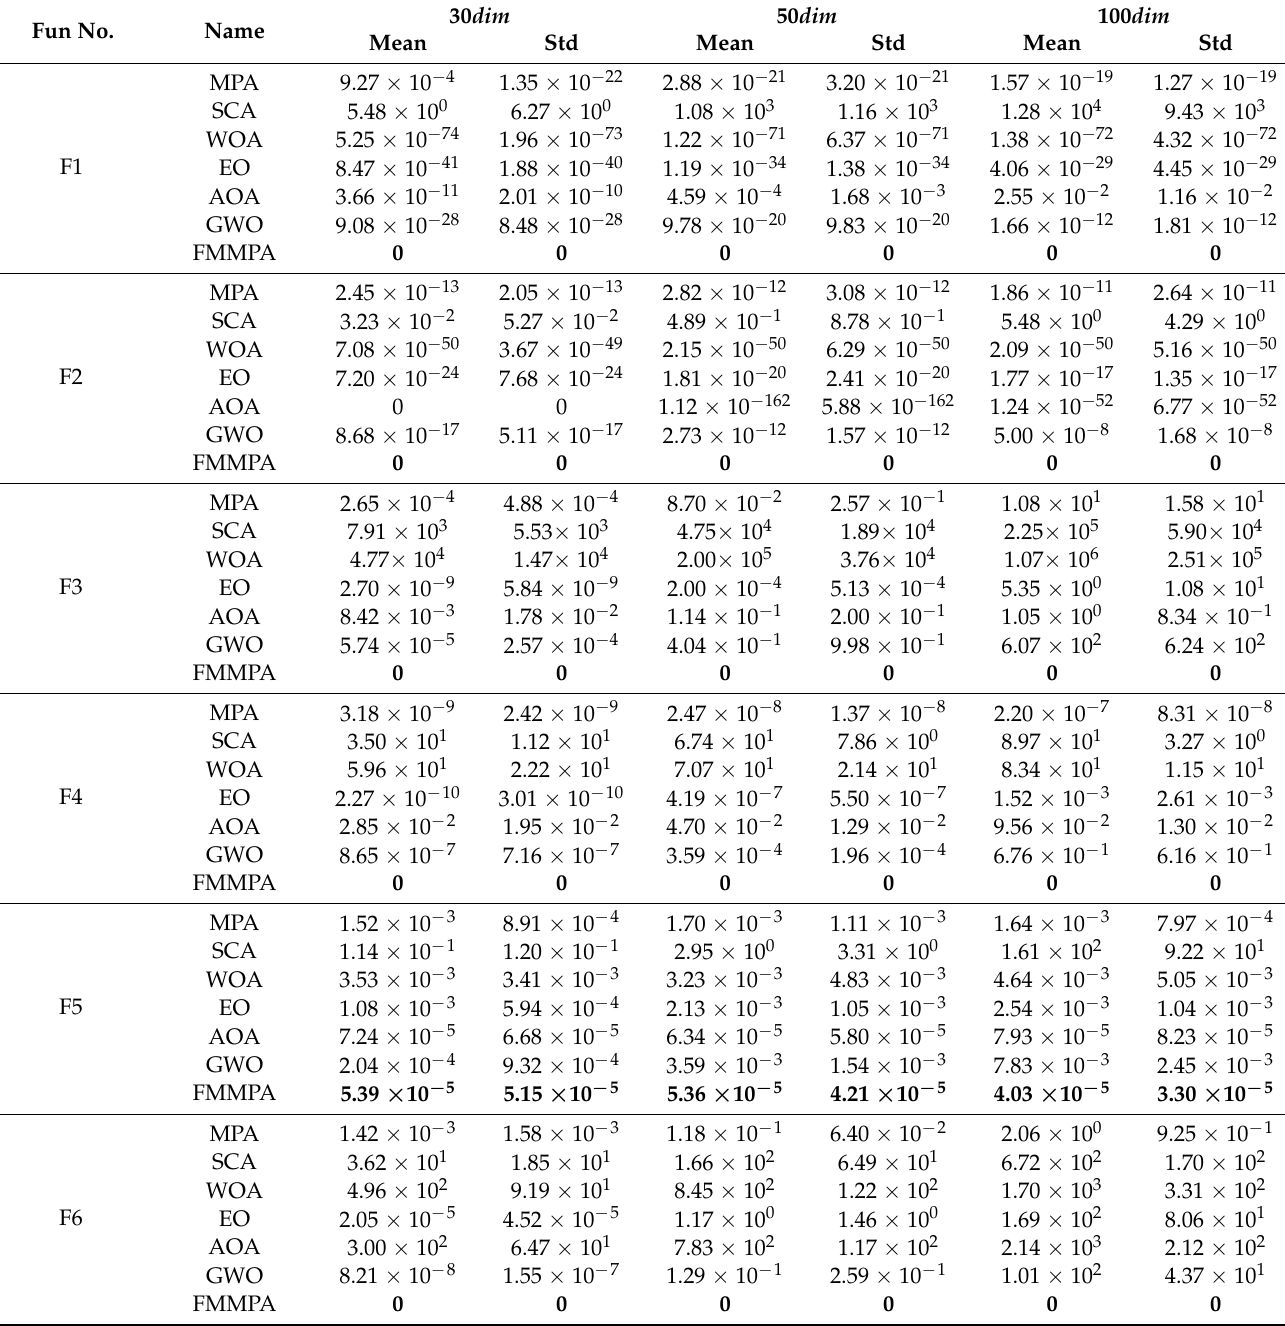
Table 3. Results of comparison with other basic algorithms in different